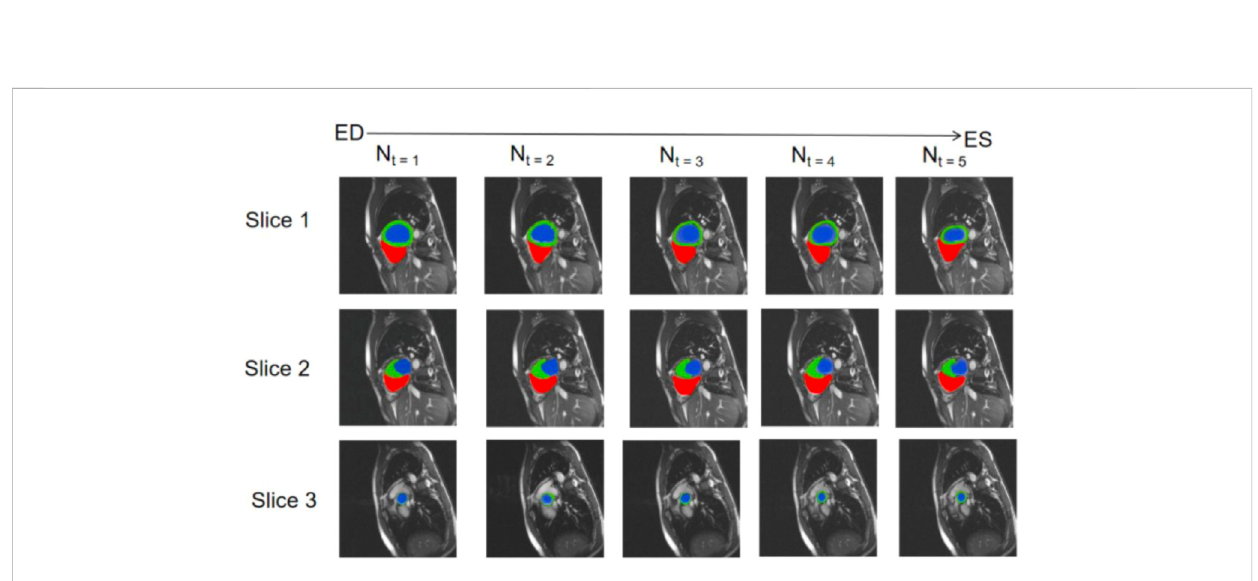
FIGURE 5 Predicted segmentation from stage ED to stage ES; red areas represent the right ventricle, green areas represent the myocardium, and blue areas represent the left